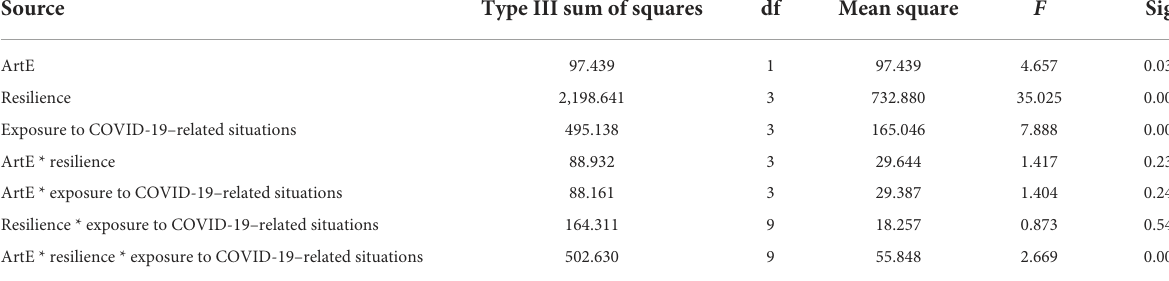
TABLE 5 Tests of between-subjects effects.